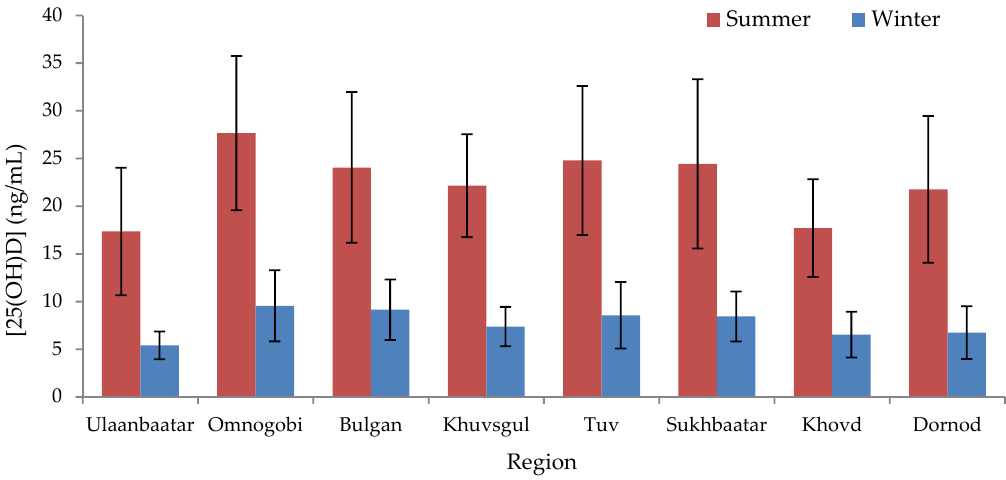
Figure 1. Mean (standard deviation, SD) serum 25(OH)D concentration by season and region. Bars indicate mean measured 25(OH)D concentrations (ng/mL) in summer (red bars) and winter (blue bars) ± SDs, summer n = 318, winter n = 307. p values for regional differences are provided in Table S2.